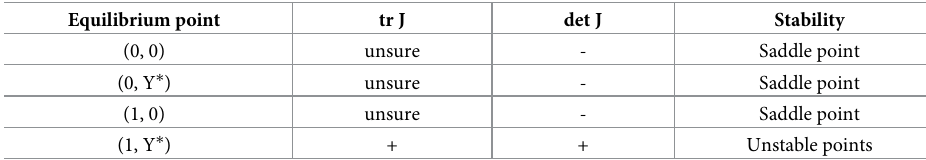
Table 4. Stability analysis of equilibrium points in case